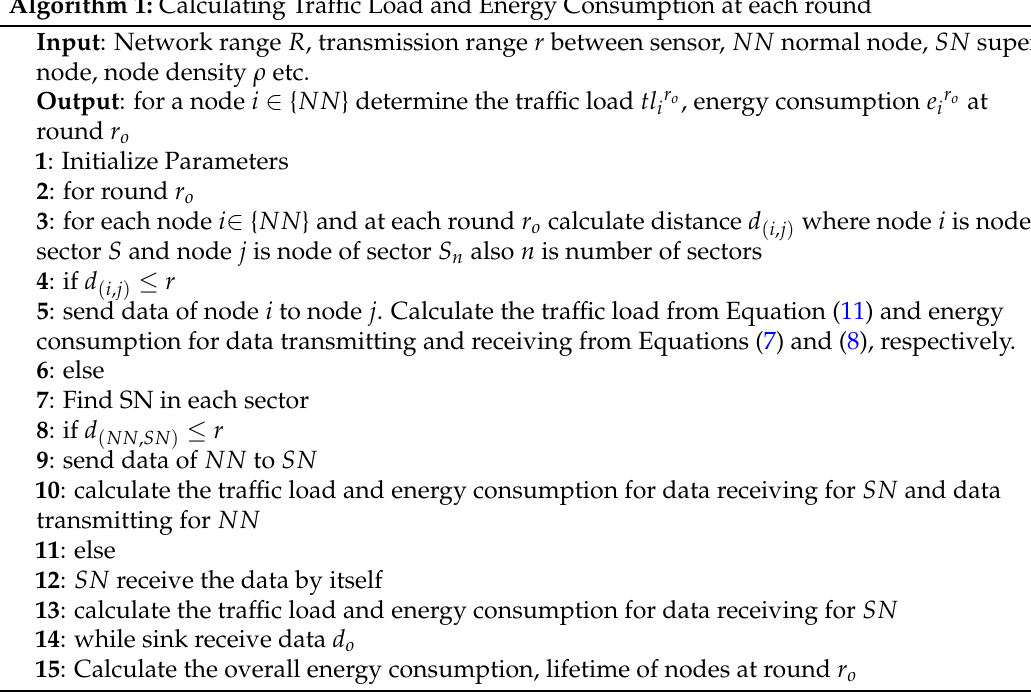
Algorithm 1: Calculating Traffic Load and Energy Consumption at each